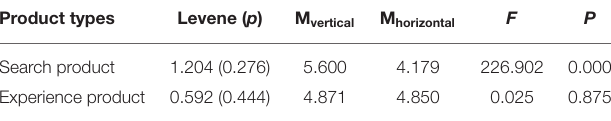
TABLE 4 | Test of product type on mediation effect.